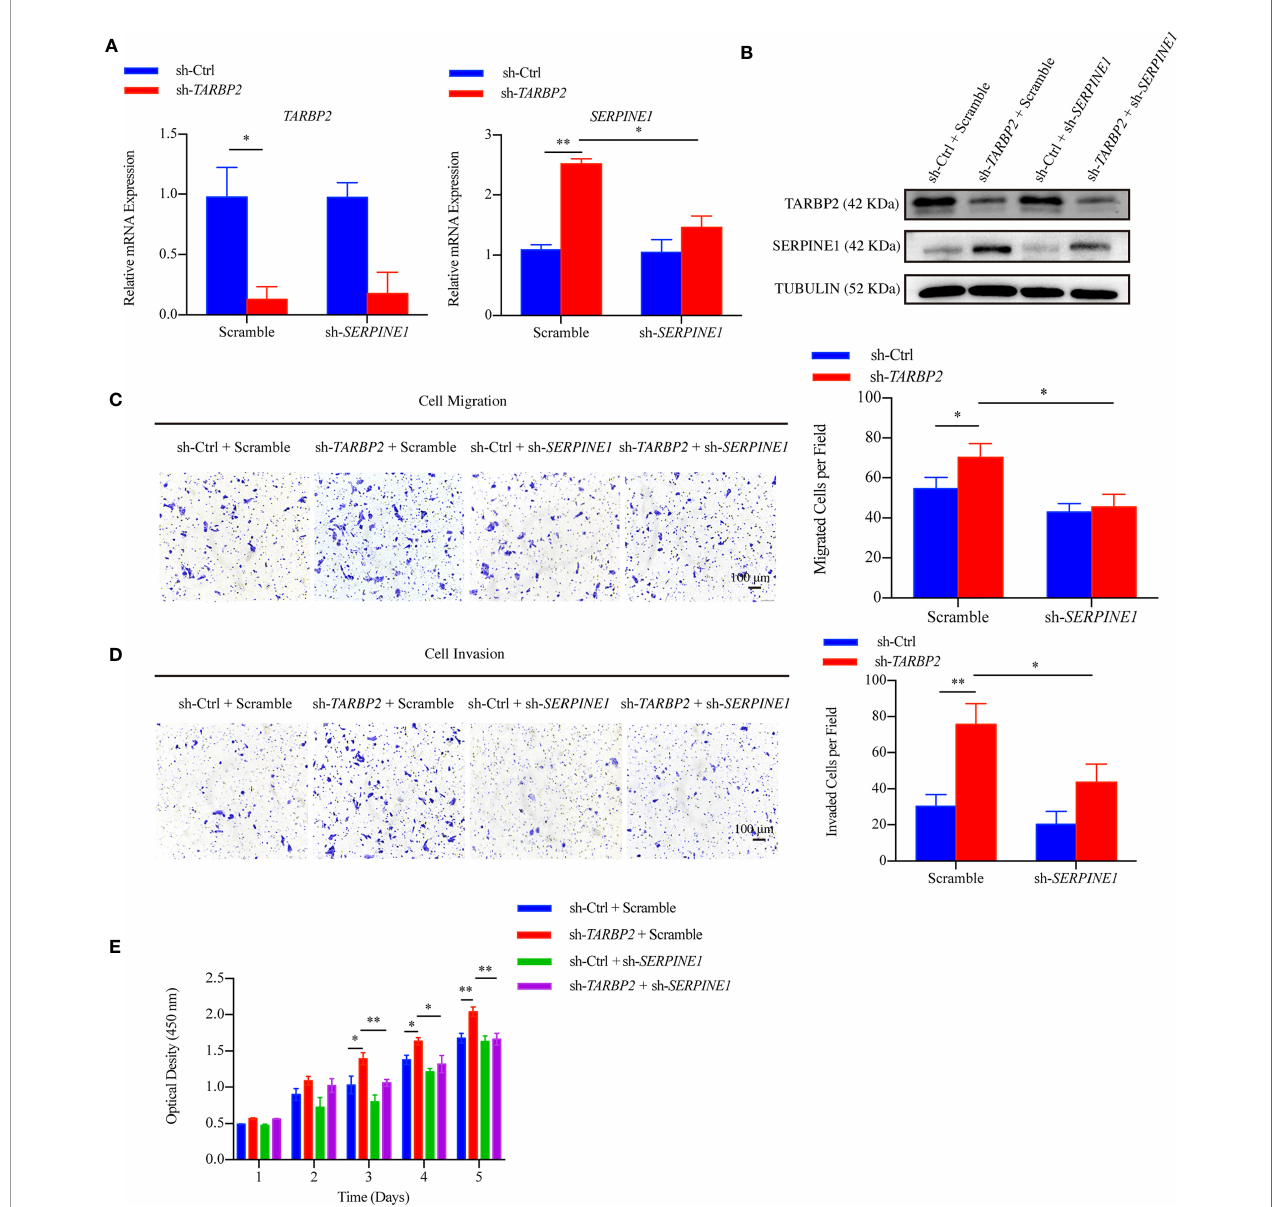
FIGURE 5 | SERPINE1 is a downstream player of TARBP2 . (A, B) The mRNA and protein expression of TARBP2 and SERPINE1 in the stable sh- TARBP2 HepG2 cells after treatment with scramble control and sh- SERPINE1 . (C) Cell migration; (D) Invasion; and (E) Proliferation assays of sh- TARBP2 HepG2 cells treated with scramble control and sh- SERPINE 1. *p-value < 0.05; **p-value <